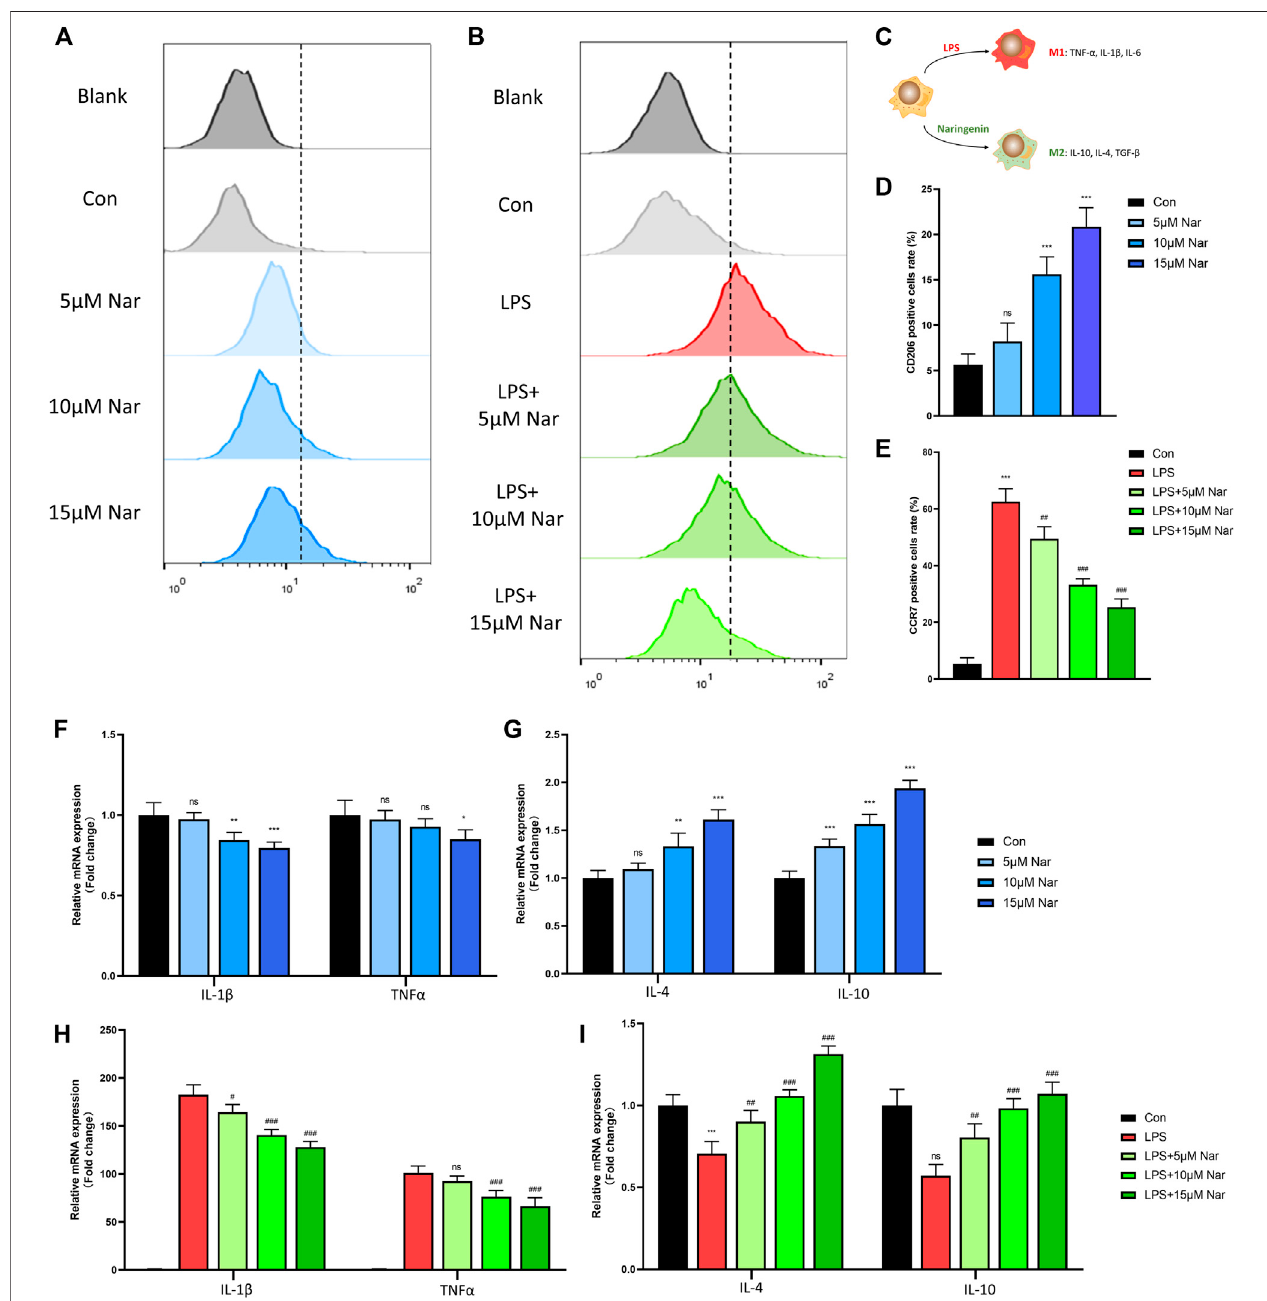
FIGURE 3 | Naringenin regulates macrophages phenotype. (A – E) CCR7 and CD206 positive cells ’ percentage of total cells analyzed by fl ow cytometry. (C) Schematic diagram of naringenin-mediated macrophage polarization. (F-I) Expressions of anti-in fl ammatory cytokines IL-4 and IL-10 as well as pro-in fl ammatory cytokinesIL-1 β and TNF- α innormal andin fl ammatory conditions. n =4per group.Dataareexpressed asmean ±SD. * p < 0.05; ** p < 0.01; *** p < 0.001;.*compared with con group.